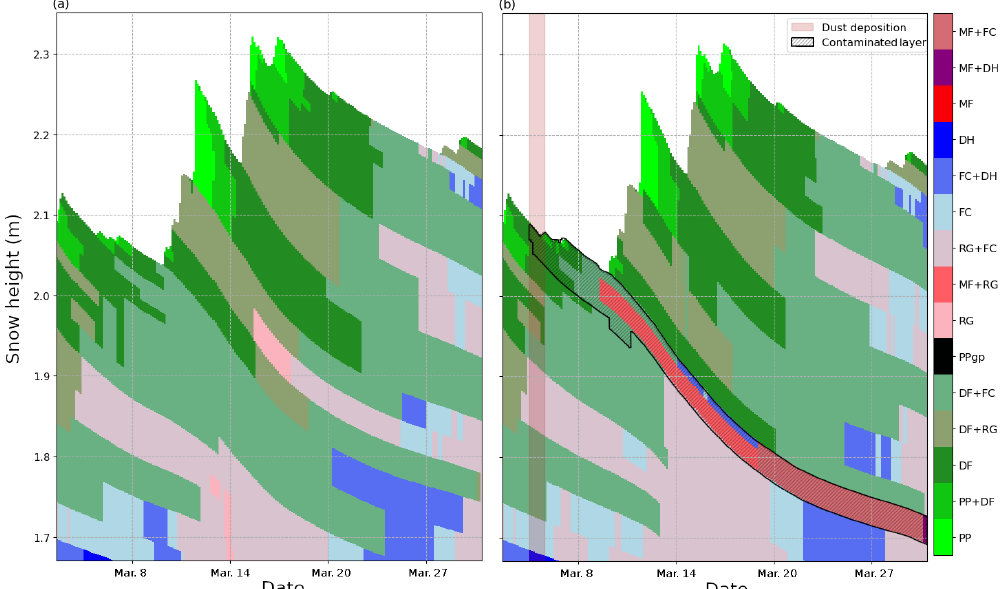
Figure 3. Zoom of Fig.